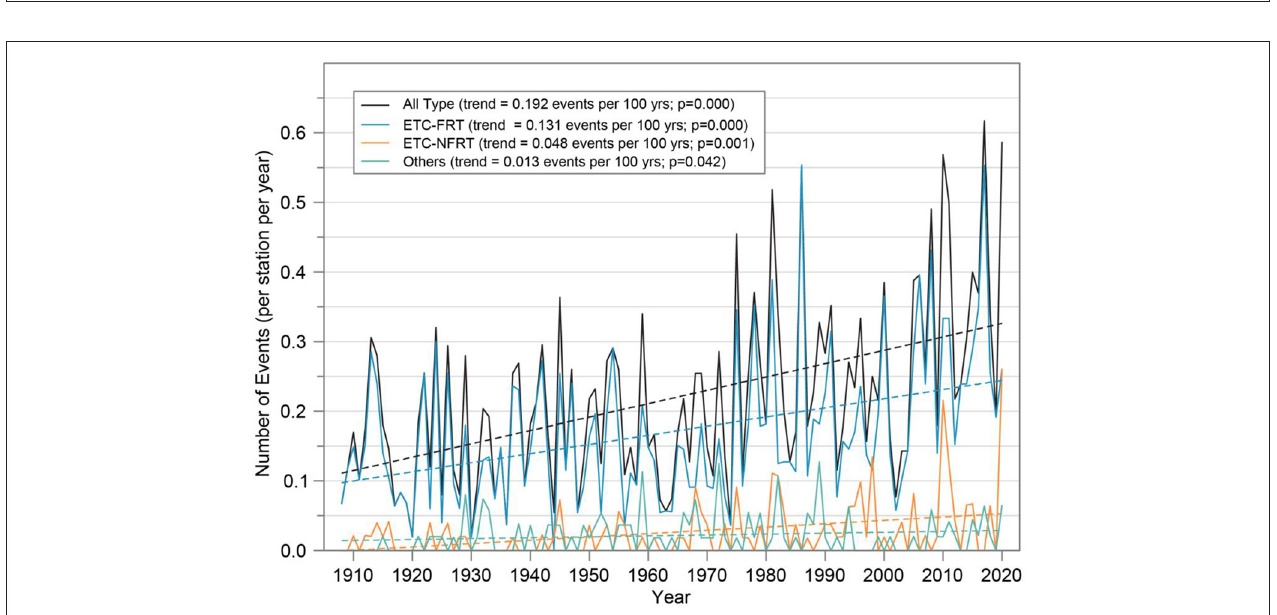
FIGURE 5 | Weather maps including (A) map of daily precipitation (mm) and (B) map of weather features, for a day (October 30, 2012) with 6 extreme events caused by a tropical cyclone (TC; Hurricane Sandy). The red dots in (A) and the white-on-purple numbers in (B) indicate the locations of the 6 events.